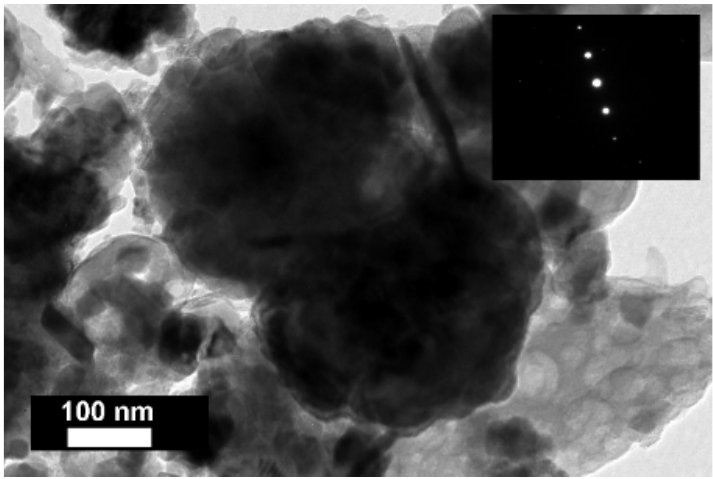
Figure 10. LREE-bearing titanium ferrotitanate observed in the bright field imaging mode of HRTEM. SAED pattern of the particle is inserted to the upper right corner. The pattern is collected from [121] direction.